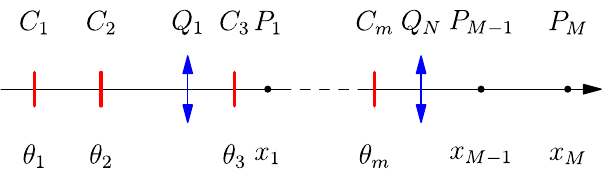
FIG. 1. Schematic of an accelerator section for parallel